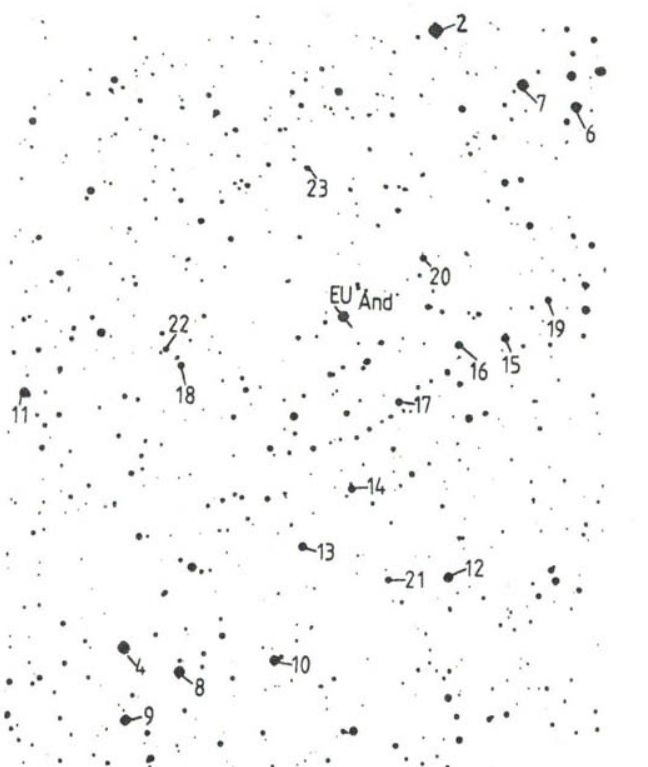
Fig. 1. Finding chart for EU And and comparison stars. North is at the top, west to the right as is also for Figs. 3 and 6. The stars Nos. 1, 3 and 5 are out of borders of the